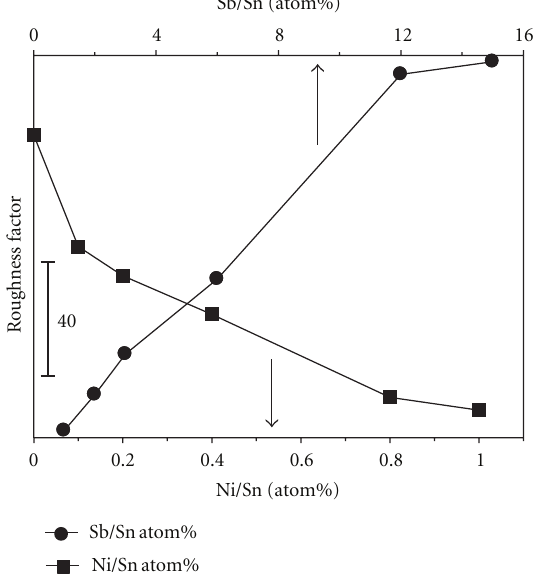
Figure 5: Variation of the estimated roughness factors ( R f ) for Ti / SnO 2 -Sb-Ni electrodes as a function of Sb and Ni concentra- tions. ( • ) Sb / Sn atom% and ( (cid:2) ) Ni / Sn atom%.